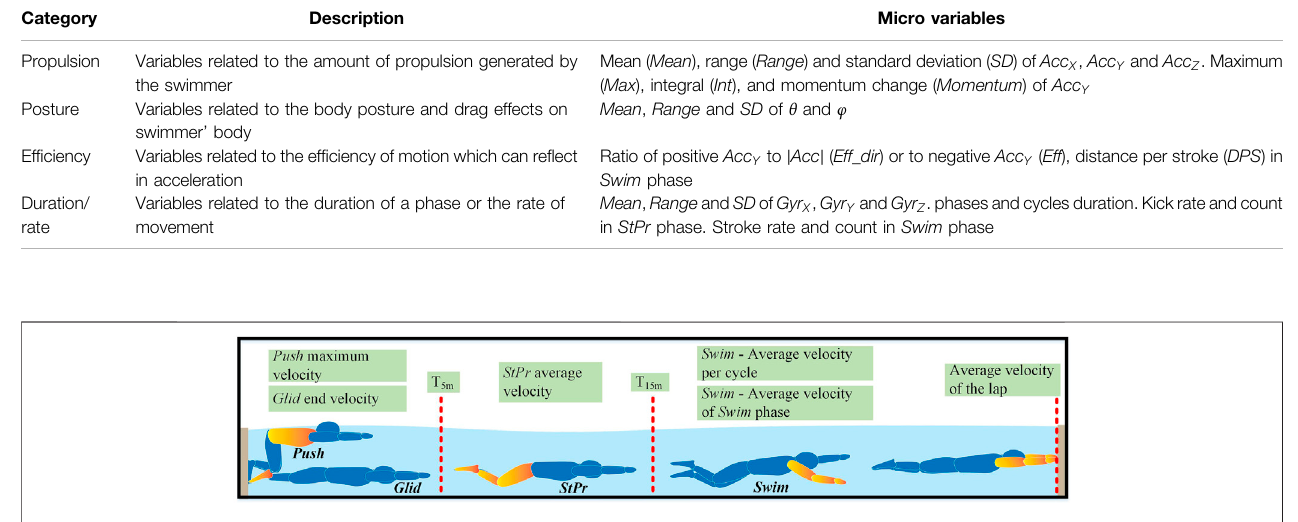
FIGURE 3 | The de fi ned goal metrics for different swimming phases from wall to